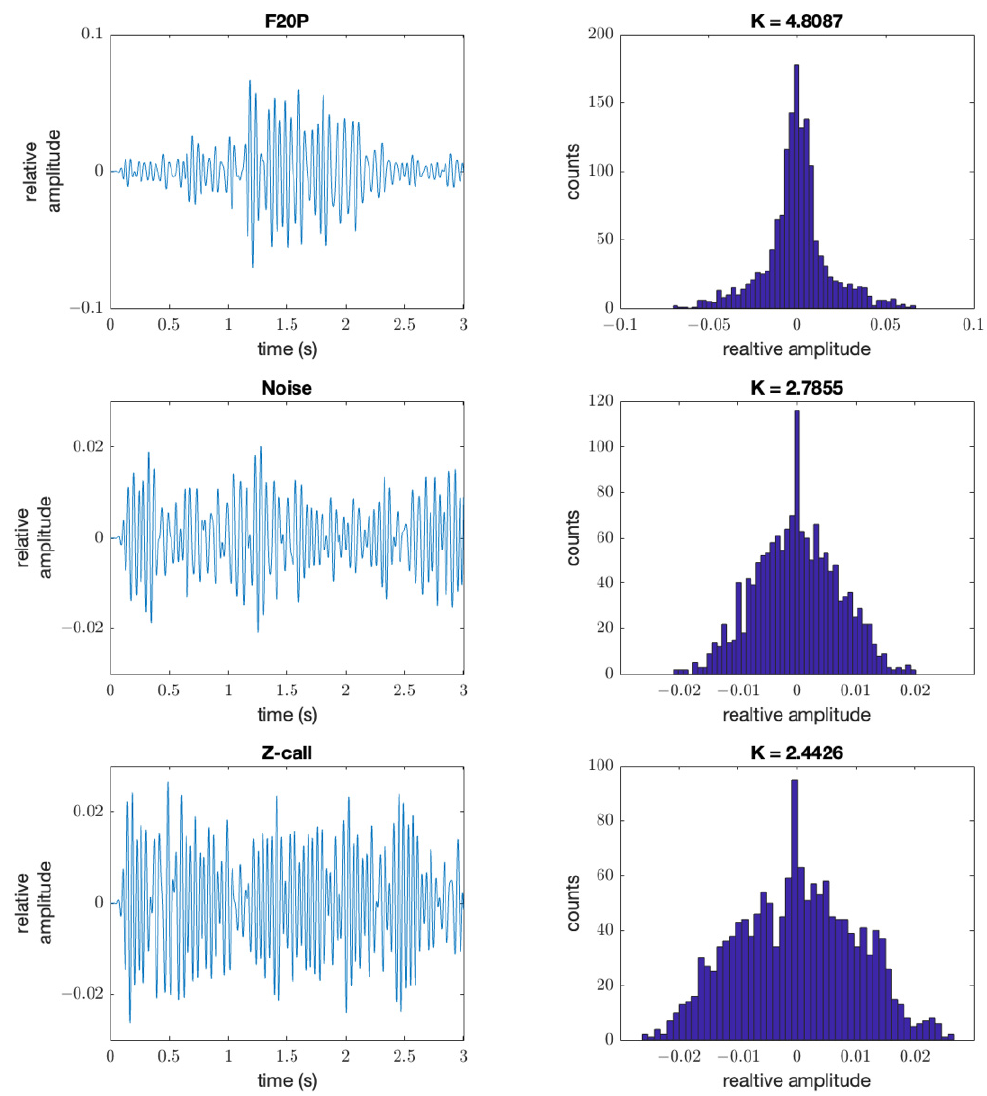
Figure 2. Amplitude waveforms and distributions of signals containing a fin whale 20 Hz-pulse (F20P), noise, and an Antarctic blue whale z-call. The respective kurtosis (K) of the amplitude distributions is given above the distribution graph.